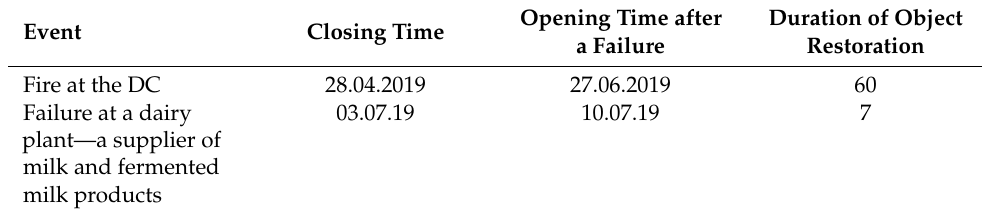
Table 4. Risk events that occurred in 2019.